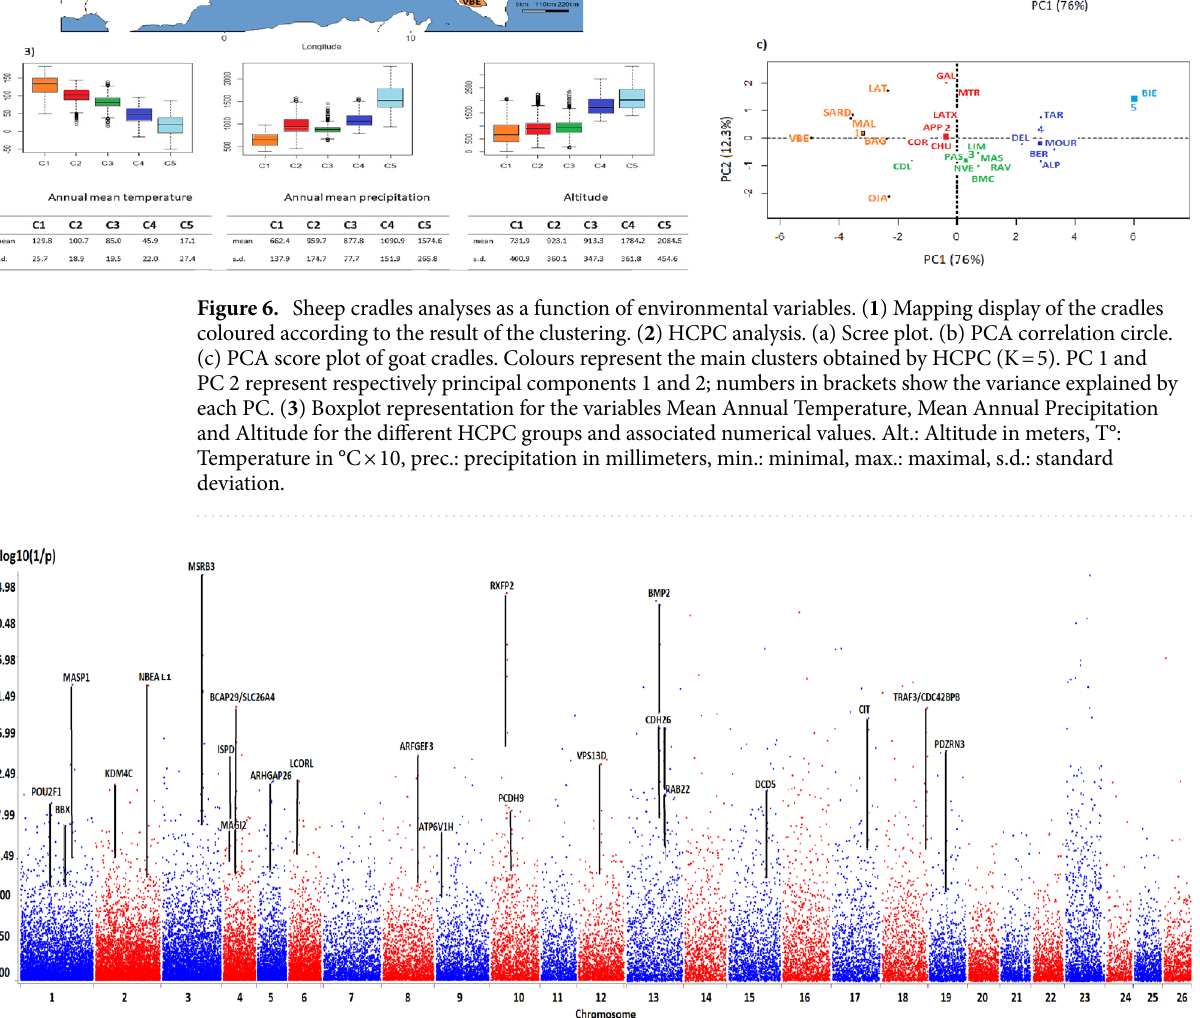
Figure 7. Genome scan for selection signature in local sheep breeds obtained by the LFMM approach and via the cradle method. Each signature was named according to the gene(s) most likely targeted by the selection process, taking into account the distance of the SNPs from the genes, the associated p values and the number of SNPs near or in the